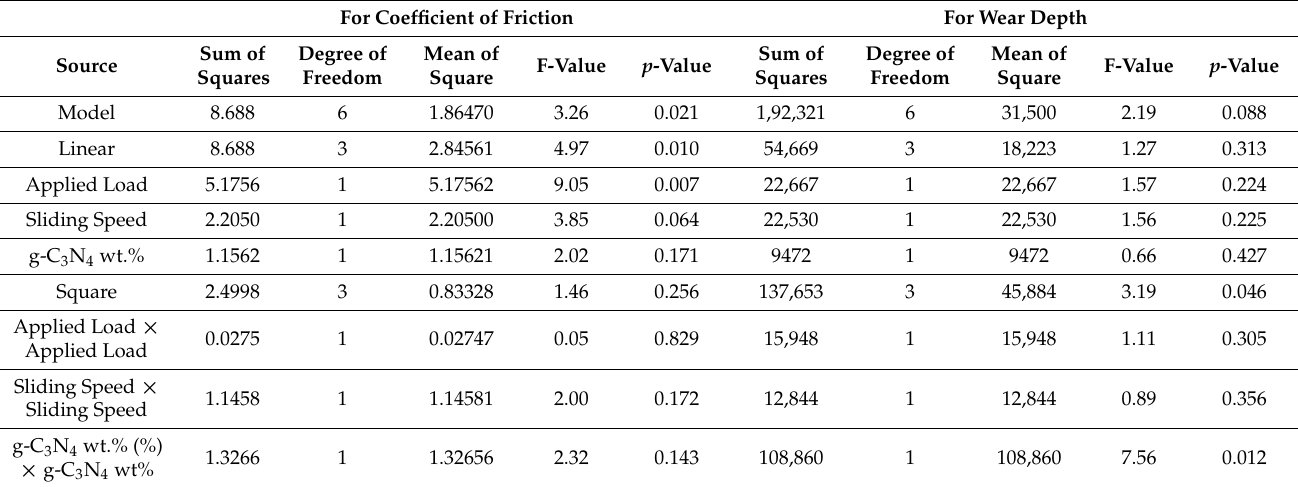
Table 7. ANOVA analysis of pin-on-disc wear test on g-C 3 N 4 /MoS 2 -nanocomposite-coated steel